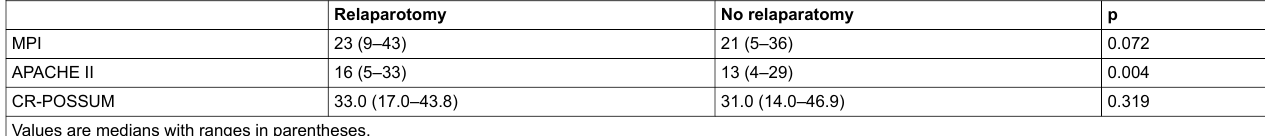
Table 2: Patients with relaparotomies showed a significantly higher APACHE II score than patients without relaparotomies.